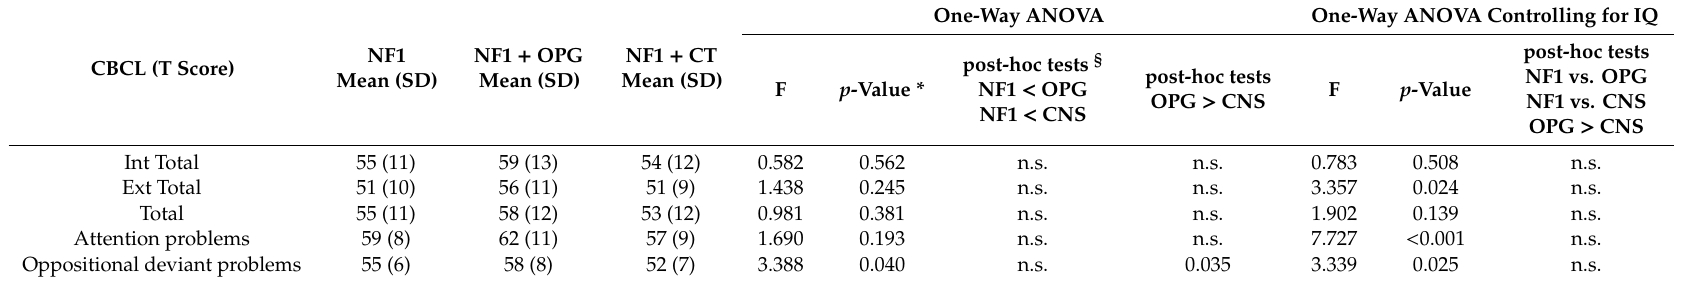
Table 3. Comparisons of the Lesion Groups at CBCL Total Scores with and without controlling for